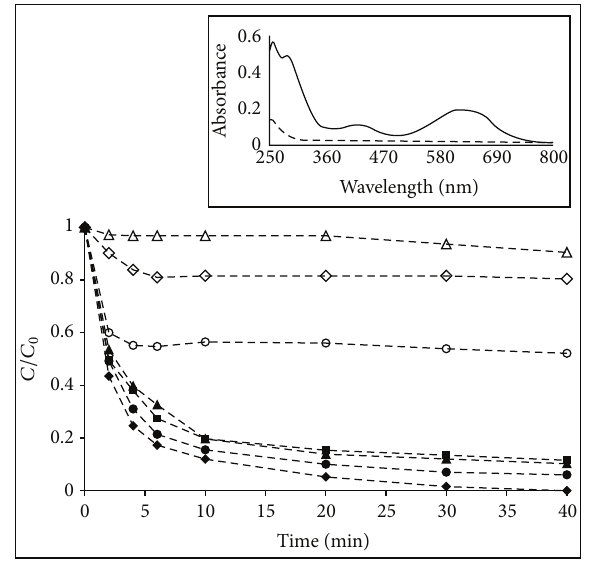
Figure 3: Normalized color removal of AG50 (4 × 10 −5 molL −1 ) at pH 2 with 37.4 mg/g catalyst annealed at 500 ∘ C using 100 mgL −1 of catalyst load by different processes: ( ⬦ ) adsorption, ( △ ) UV light only, ( I ) Us only, ( 󳵳 ) Fenton reaction (F), ( ◼ ) F + UV light (UV), ( e ) F + ultrasound (Us), and ( X ) F + UV + Us. The insert shows the absorbance spectra during dye degradation: initial (continuous line) and final at 40min (dashed line) in the F + UV + Us.